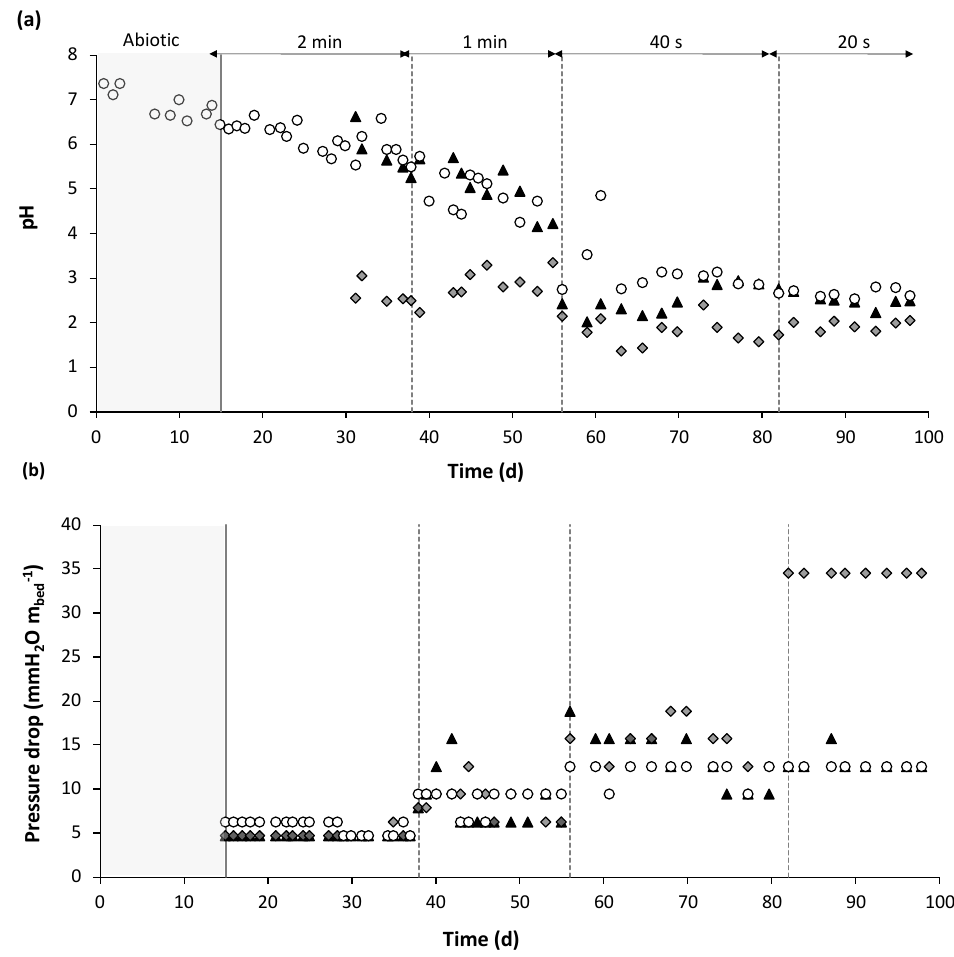
Figure 5. Time course of ( a ) pH and ( b ) pressure drop in the BF-F ( (cid:7) ), the BF-FAC ( (cid:78) ) and the 2PBTF-F ( ). Vertical dashed lines delimit different stages.